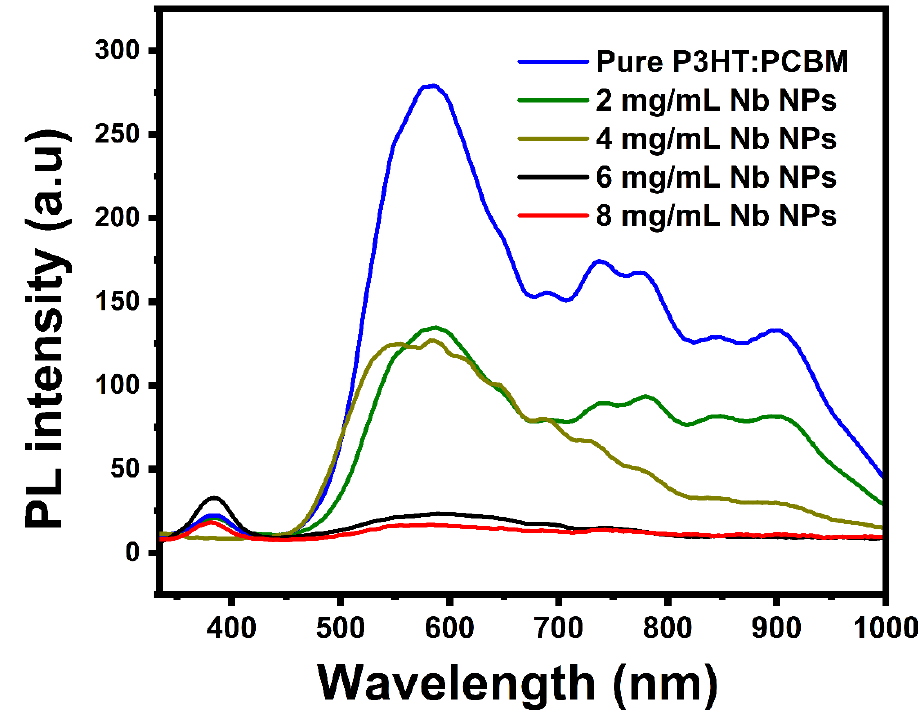
Figure 7. Photoluminescence (PL) spectra of pure P3HT:PCBM and P3HT:PCBM:Nb thin films produced with different amounts of Nb nanoparticles.